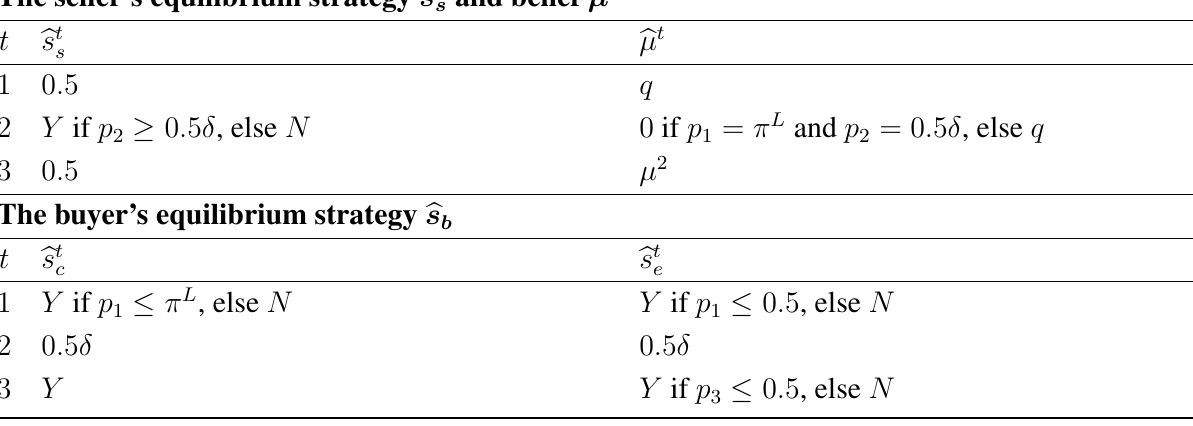
Table 1. Strategies and beliefs if q ≤ 0 . 5